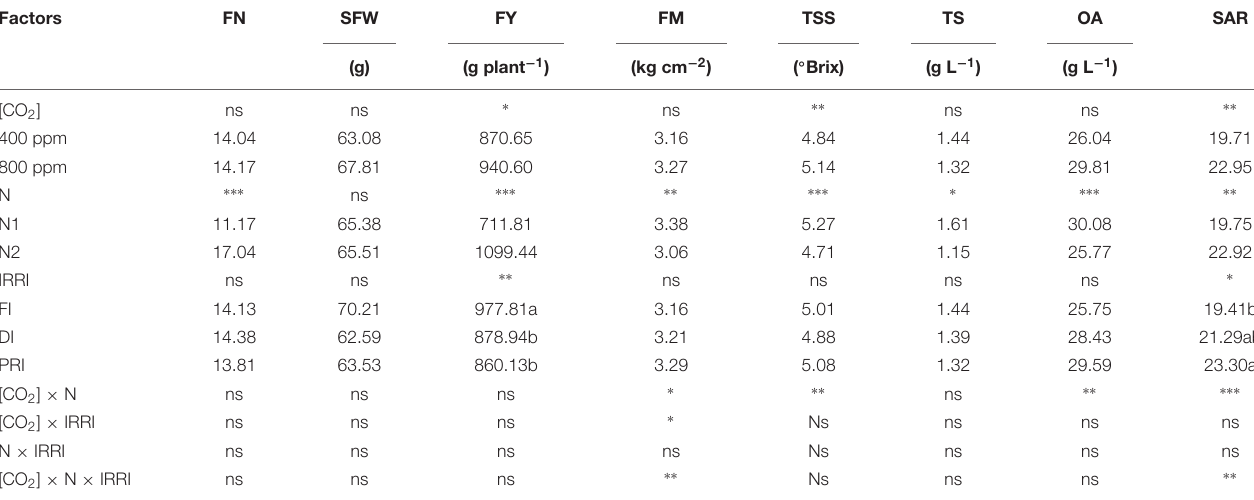
The table reported the significance results of the three-way ANOVA on total fresh fruit number (FN), single fresh fruit weight (SFW), total fresh fruit yield (FY), fresh fruit firmness (FM), total soluble solid (TSS) concentration, total sugar (TS) concentration, organic acid (OA) concentration, fruit sugar to acid ratio (SAR), and each mean value of the main factors ([CO 2 ] 400 and 800 ppm, N1 and N2, FI, DI, and PRI) of tomato plants as affected by the CO 2 environment ([CO 2 ]), nitrogen fertilization (N), and irrigation regimes (IRRI) and their interactions. ∗ , ∗∗ , and ∗∗∗ indicate significance levels at P < 0.05, P < 0.01, and P < 0.001, respectively; ns denotes no significance. Different letters at sampling data under irrigation treatments (IRRI) indicate significant differences between treatments according to LSD’s multiple range test at P < 0.05.